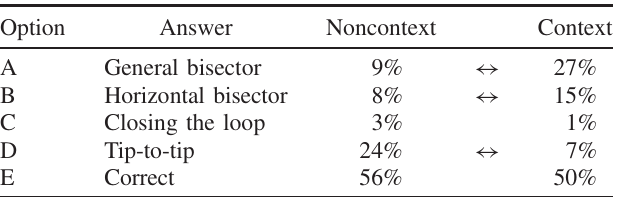
TABLE XII. Results of item 1: Students have to choose the vector or force addition in 2D. Arrows indicate significant differences.